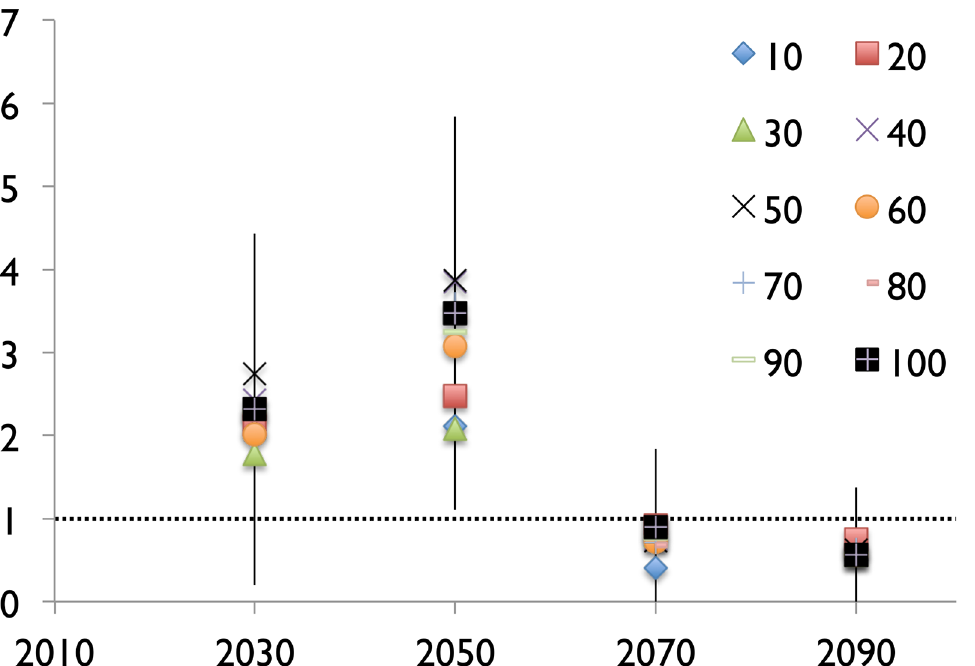
Fig 5. Effect of Maxent sample size on predictions. Scatterplot of mean habitat suitability index for 10 – 100% of remote Pacific locations used in training, plotted for 2030, 2050, 2070, and 2090. Error bars show 2x standard deviation of dataset using 100% of the potential locations for Maxent training. Dashed line indicates Maxent training value; plot is normalized to training values. The results show that the values obtained from as little as 10% of data points are well within the standard deviation of 100% of data points, giving Maxent results weight even for small sample sizes of training data.